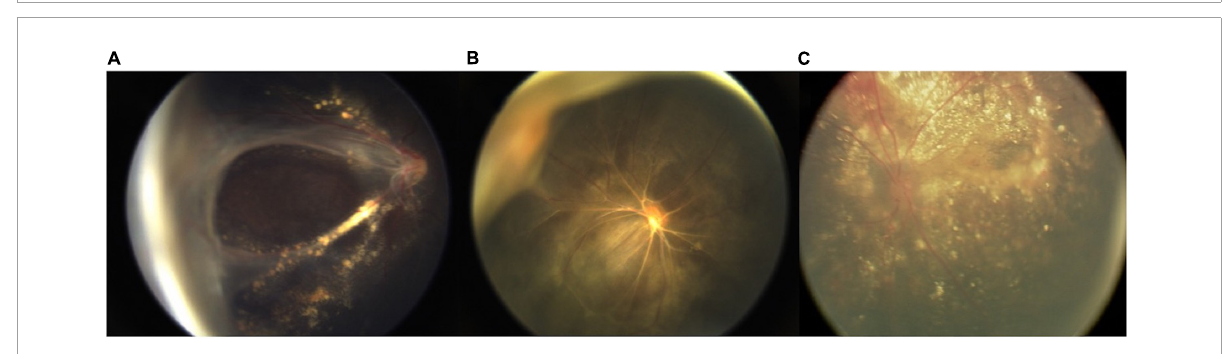
FIGURE4 Different degrees of retina reattachment. Partial reattachment with posterior retina detached (A) . Major reattachment with peripheral retinal detached (B) . Total reattachment (C) .